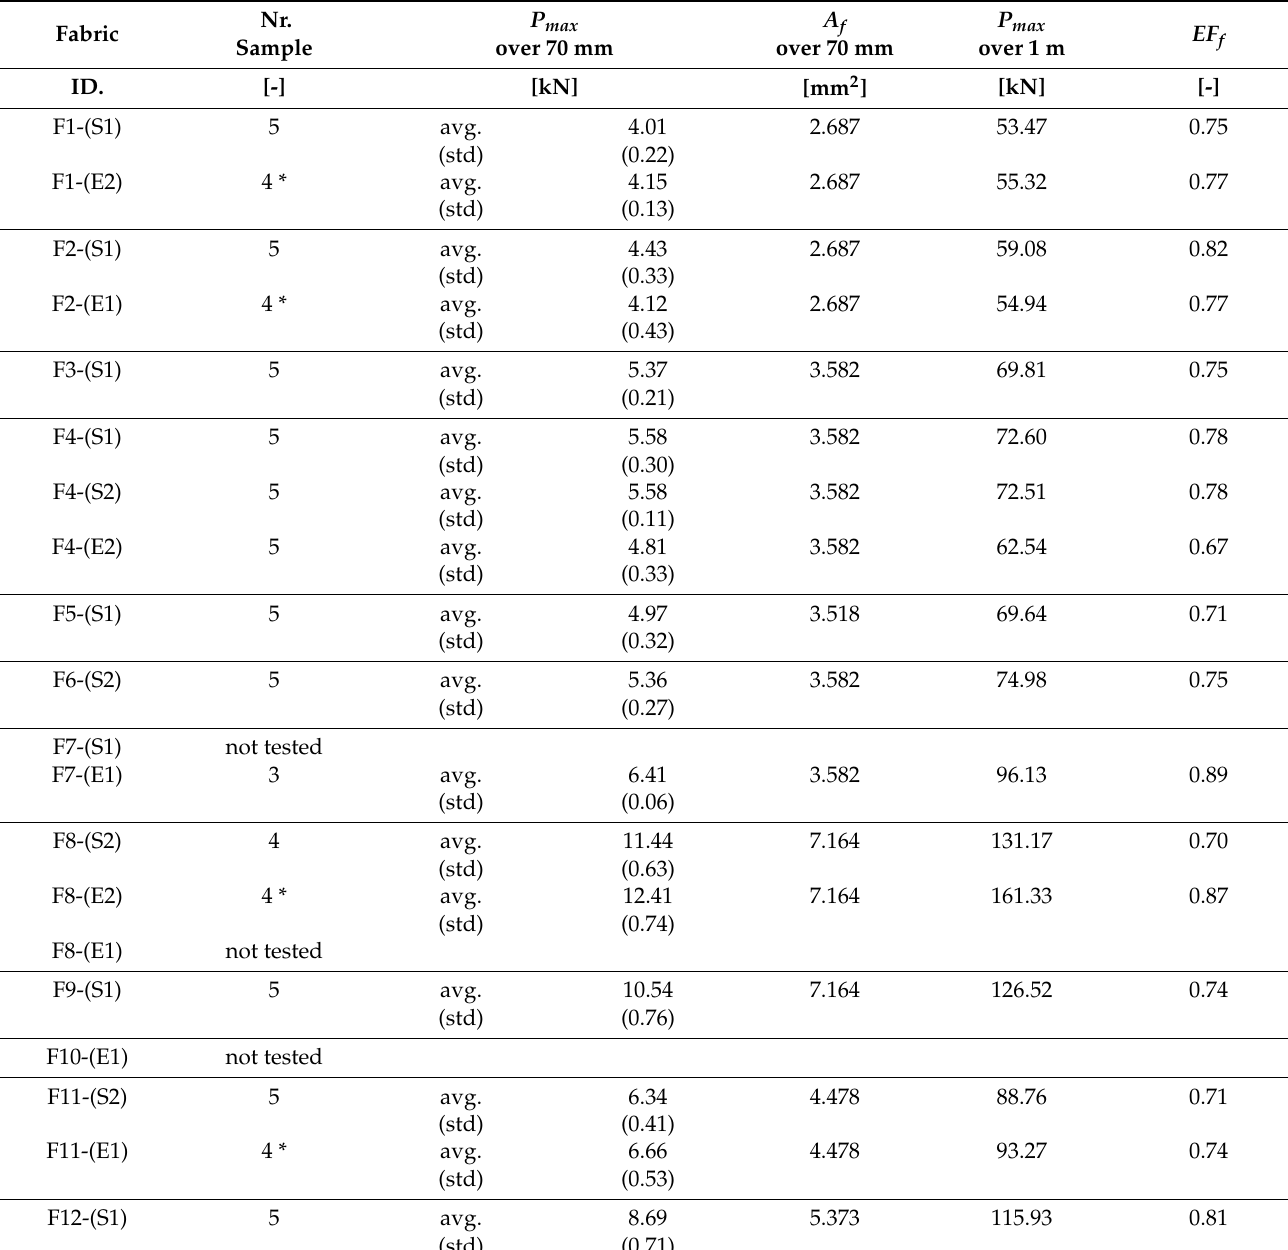
Table 4. Tensile test results in the weft direction of the AR-glass textiles.